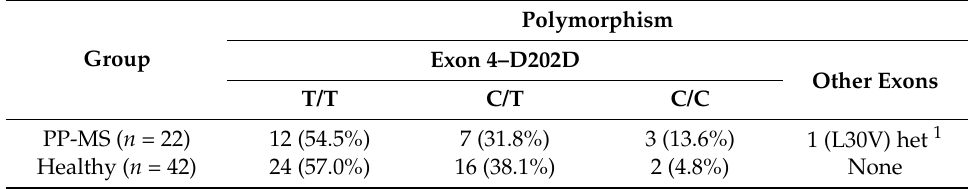
Figure 1. Polymorphisms/mutations in proteolipid protein (PLP): ( a ) Exon 4 polymorphism: the three panels on the left show the DNA sequences of exon 4 of individuals who are homozygous at T (top), homozygous at C (center), or heterozygous at this position. ( b ) Exon 2 mutation: the top panel shows the wildtype sequence seen in a healthy woman, and the bottom panel shows a C > G mutation found in a female patient with primary progressive multiple sclerosis (PP-MS). This mutation results in a coding change from CTG (leucine) to GTG (valine). Table 2. Frequency of PLP1 polymorphisms in female patients with primary progressive multiple sclerosis (PP-MS) and in healthy female controls.